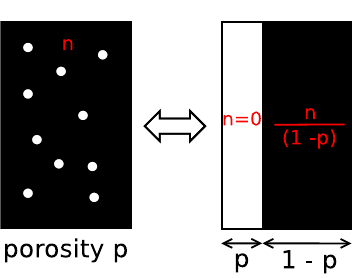
Figure 4. Porosity p in the real sample (left) and model used for transmission (right)